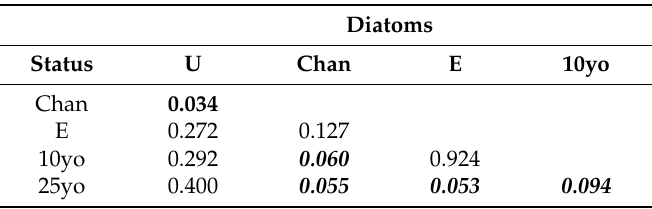
Table 4. Results of PERMANOVA for pairwise comparisons to test for differences in diatom community composition among streams that were unchannelized (U), channelized (Chan), restored using enhanced (E) techniques 2 years ago, restored using best-practice techniques about 10 years ago (10yo) or about 25 years ago (25yo). Significant p -values are in bold ( α = 0.05) or in bold italics ( α =